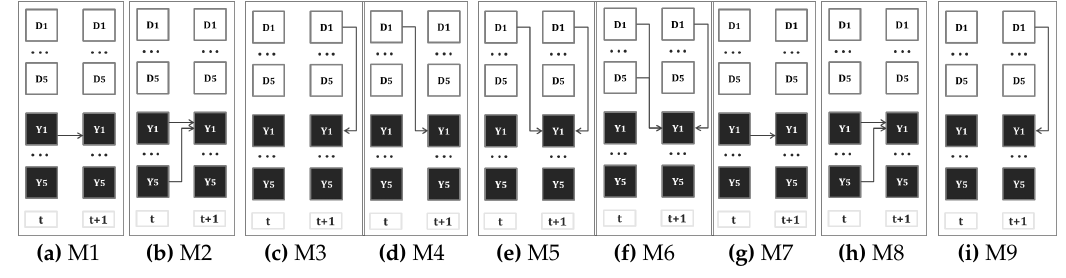
Figure 3. Markov chain model (MCM)